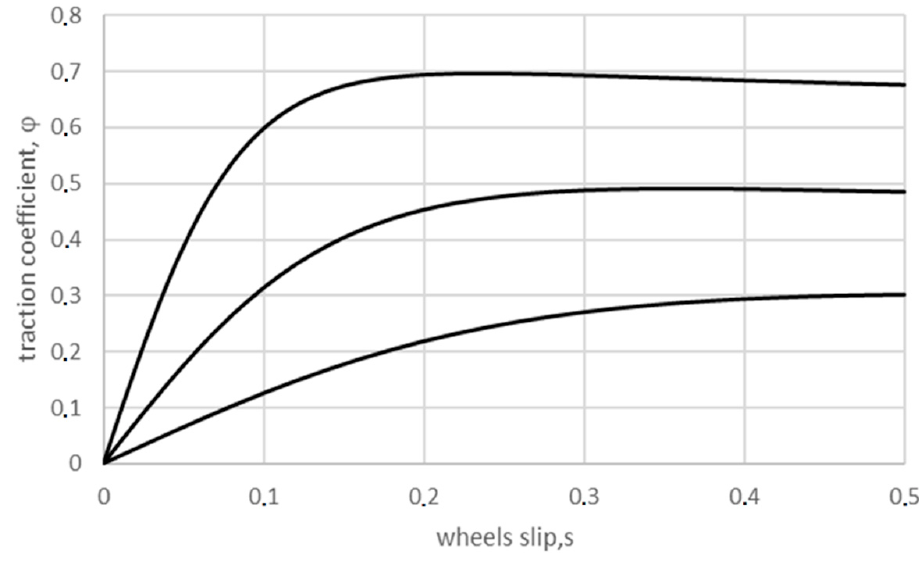
Figure 7. Plot of the traction coefficient of the wheel model as a function of slip.